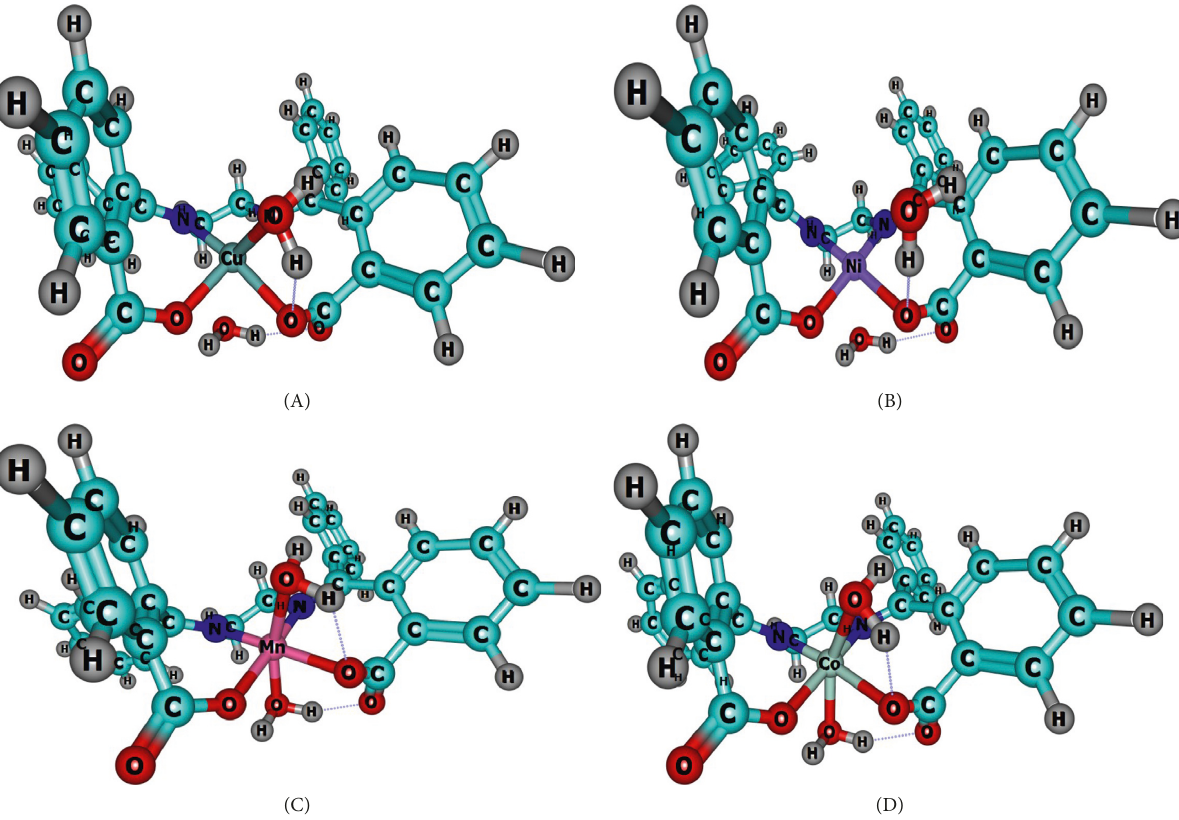
Figure 2: The optimized geometries of [ Cu ( EDA 2 BB )( OH [ Co ( EDA 2 BB )( OH